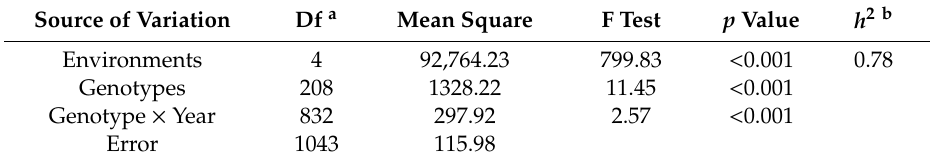
Table 2. Analysis of variance and heritability for FHB index in DH population across two years. Source of Variation Df a Mean Square F Test p Value h 2 b Environments 4 92,764.23 799.83